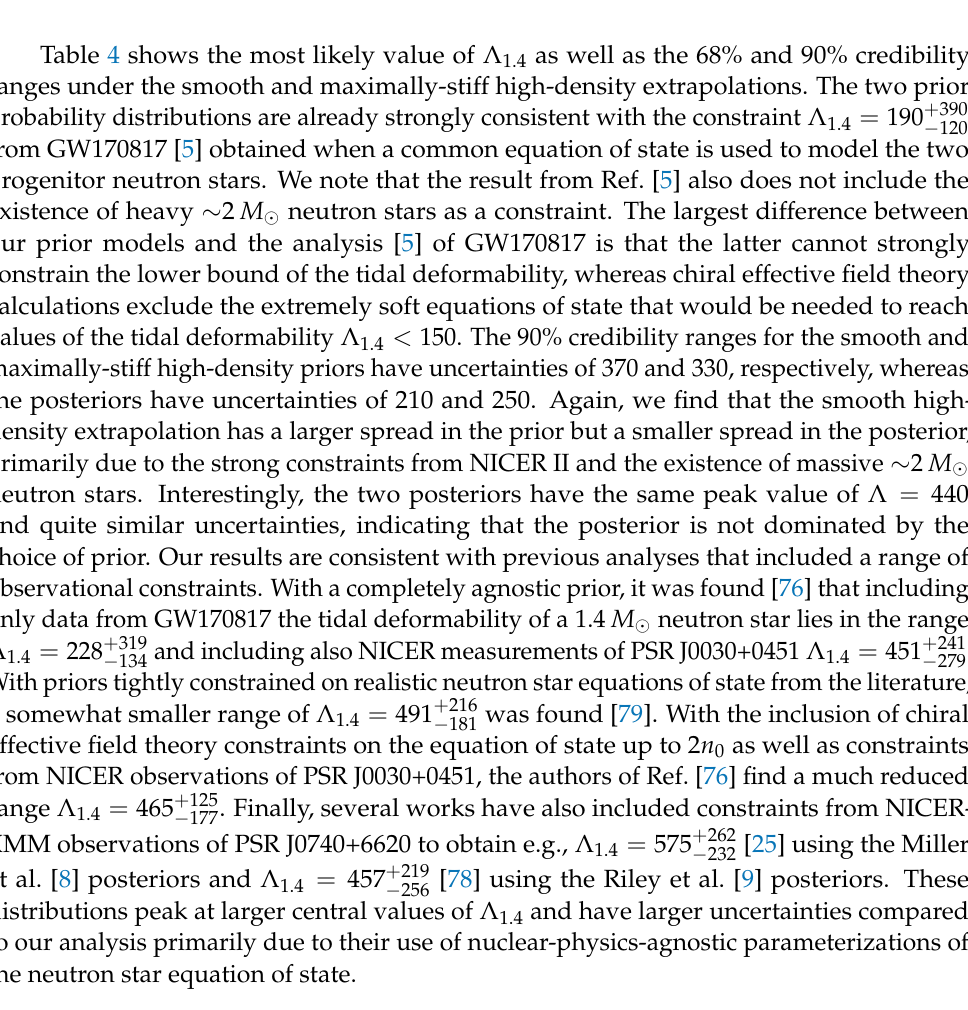
Table 4. The 68% and 90% credibility ranges for Λ 1.4 associated with the smooth and maximally-stiff high-density priors as well as the two posteriors accounting for all likelihood functions included in this